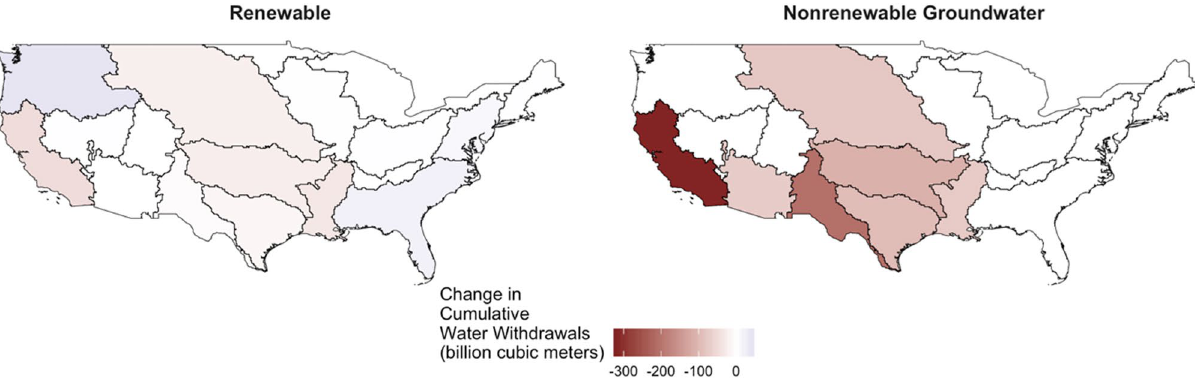
Figure 1. Impact of sustainable water measures on 2015–2100 cumulative water withdrawals (km 3 ) by source. Difference between cumulative water withdrawals from renewable and nonrenewable sources from the Sustainable GW and Reference scenarios. Positive values represent increases in withdrawals after sustainable measures are implemented, whereas negative values represent declines in overall withdrawals when compared to the reference